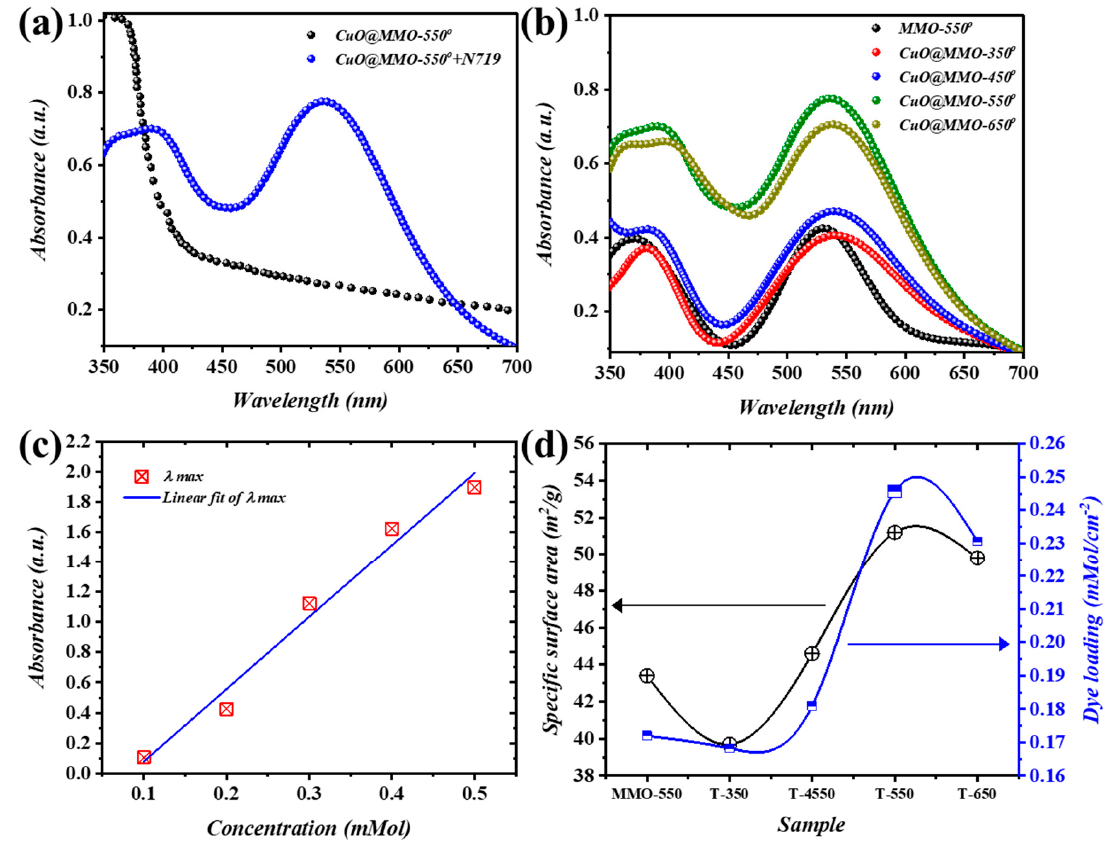
Figure 4. ( a ) Absorption spectra of MMO-550° and CuO@MMO-550° containing N719, ( b ) spectral response of the annealed films, ( c ) linear fit of maximum absorbance @ 525 nm, and ( d ) variation of the specific surface area (black) and dye N719 loading amount (blue).